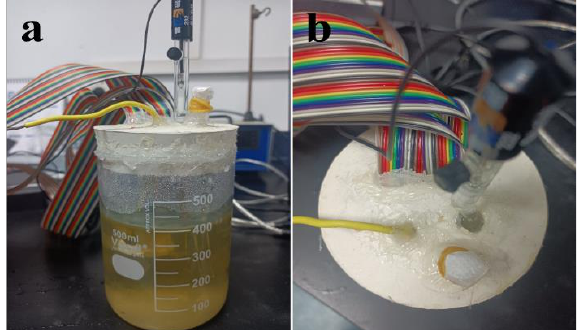
Figure 2. Photos of the front view ( a ) and top view ( b ) of the device for studying coating degradation and metal corrosion using WBE.